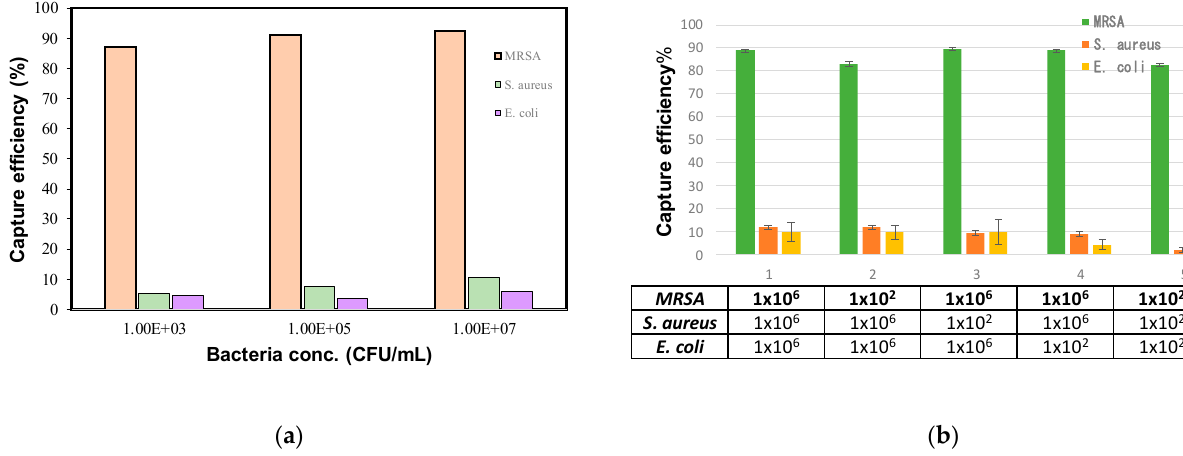
Figure 4. ( a ) Capture efficiency of different FITC-labeled bacteria (MRSA, S. aureus , E. coli ) at different concentrations (10 3 , 10 5 , 10 7 CFU/mL). ( b ) Selectivity of aptamer-modified nanoparticles examined in bacteria mixtures containing various ratios of the three species.